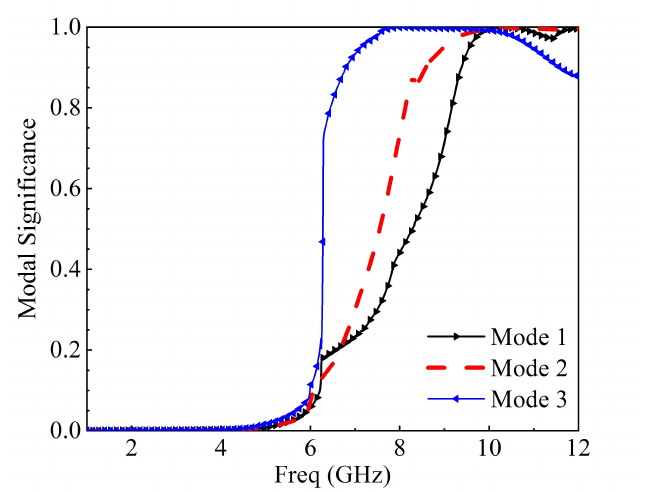
Figure 6. Modal significance at 5.2 GHz.